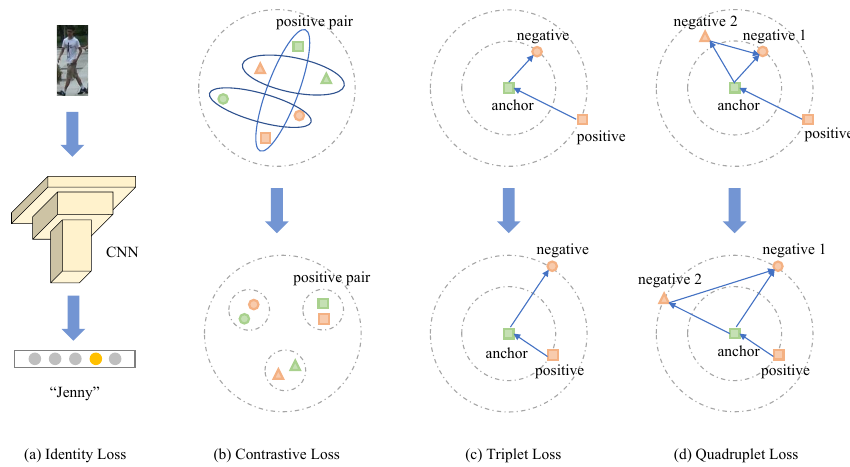
Figure 6. Four widely used loss functions. Different shapes denote different IDs, while the different color represents different modality. ( a ) Identity loss, ( b ) contrastive loss, ( c ) triplet loss, ( d ) quadruplet loss. Many works employ their